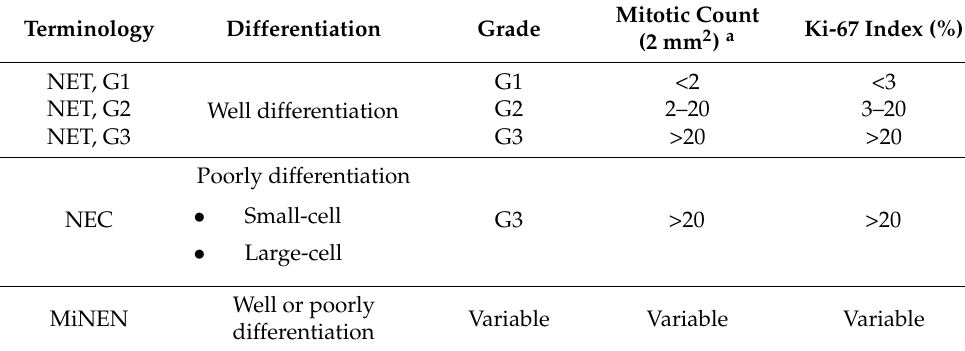
Table 1. WHO 2019 classification for GEP-NENs [6].